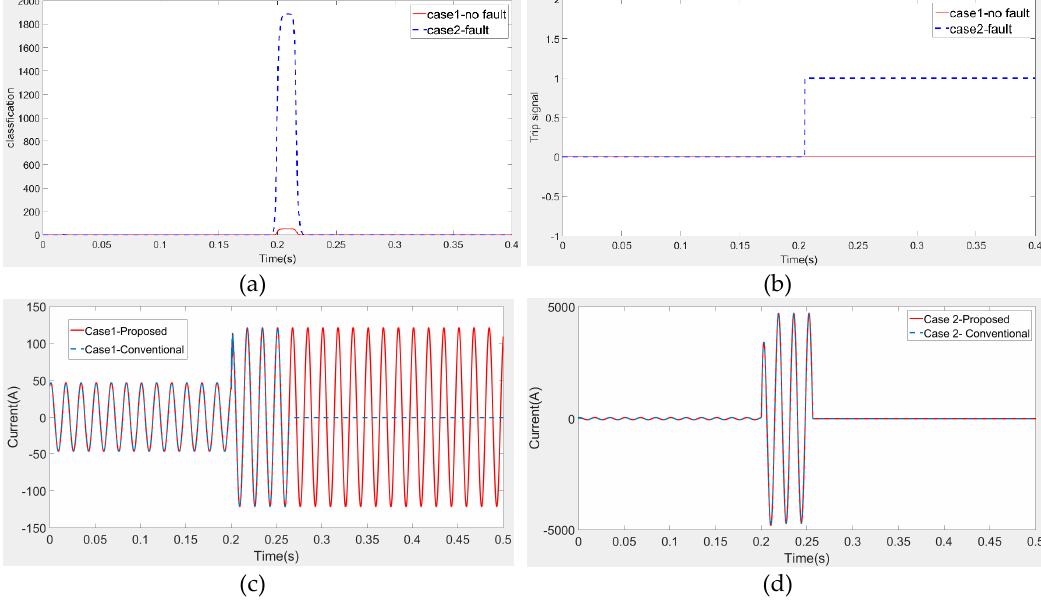
Figure 17. Simulation results of case 1 and 2. (a) Calculation result of classification value; (b) Trip signal; (c) Current flowing in the Y line in case 1; (d) Current flowing in the Y line in case 2.